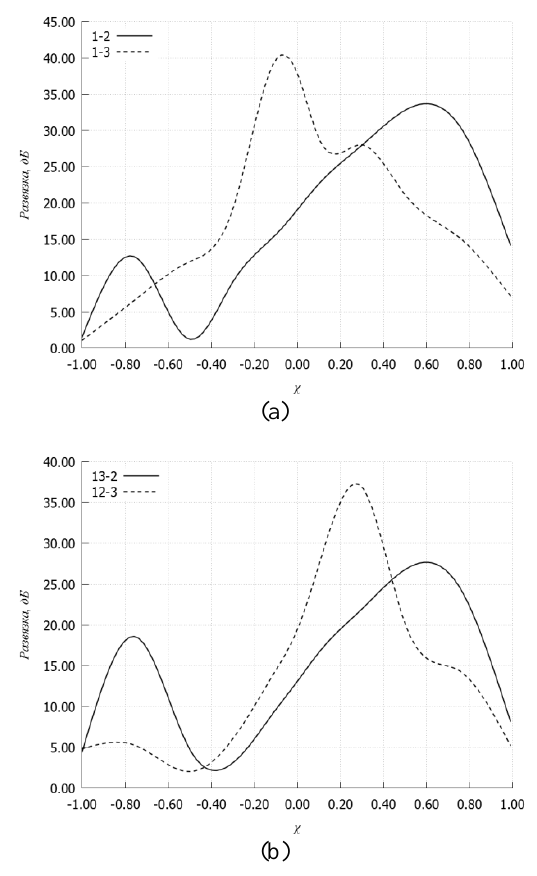
Fig. 4. Dependence of the isolation between the emitters of a three-element MEAA on the chirality